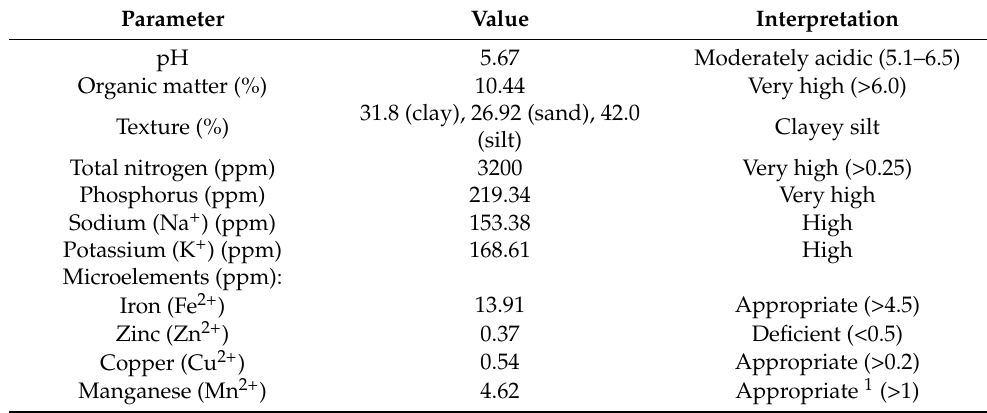
Table 1. Physicochemical properties of agricultural soil not contaminated by waste motor oil.